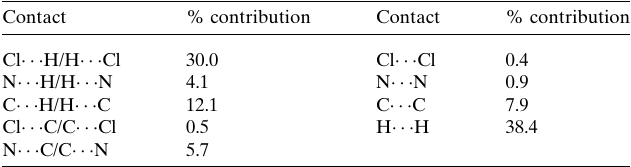
Table 4 Percentage contributions of interatomic contacts to the Hirshfeld